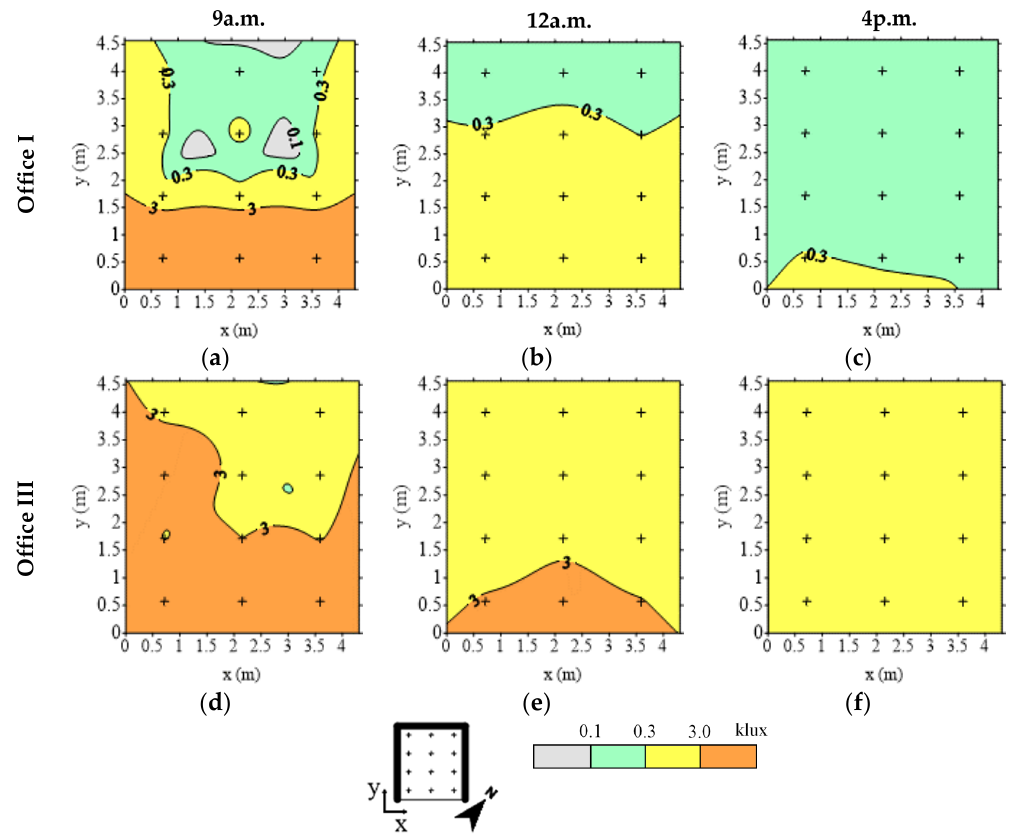
Figure 16. Mapping of the indoor daylight levels (UDI metric ranges) on the work plane, measured on a clear sky day during the cooling period: ( a–c ) office I with SCF A ( a : 9 a.m; b : 12 a.m.; c : 4 p.m.); ( d–f ) office III without SCF ( d : 9 a.m.; e : 12 a.m.; f : 4 p.m.).